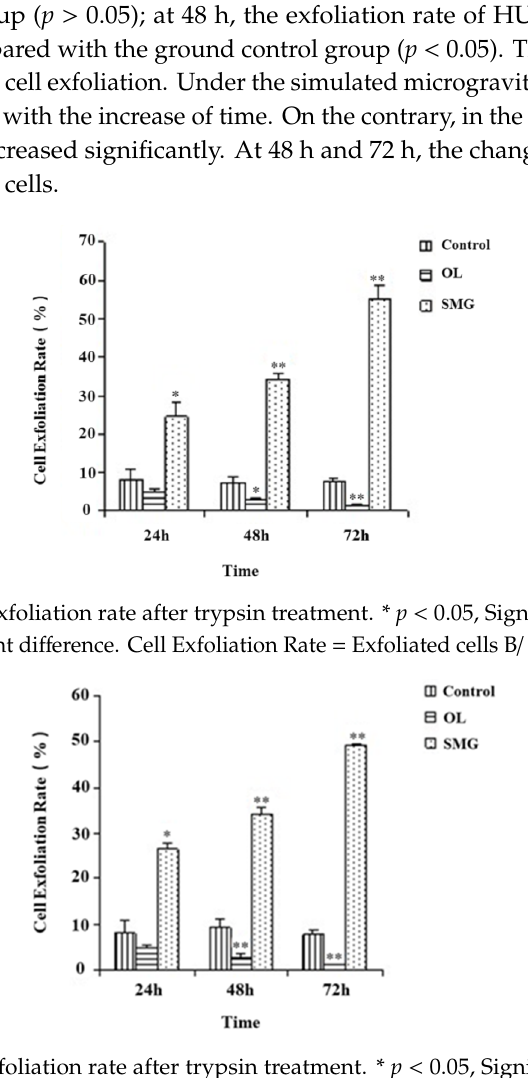
Figure 2. MCF-7 cell exfoliation rate after trypsin treatment. * p < 0.05, Significant difference; ** p < 0.01, extremely significant difference. Cell Exfoliation Rate = Exfoliated cells B/ Total Number A ( n = 3).